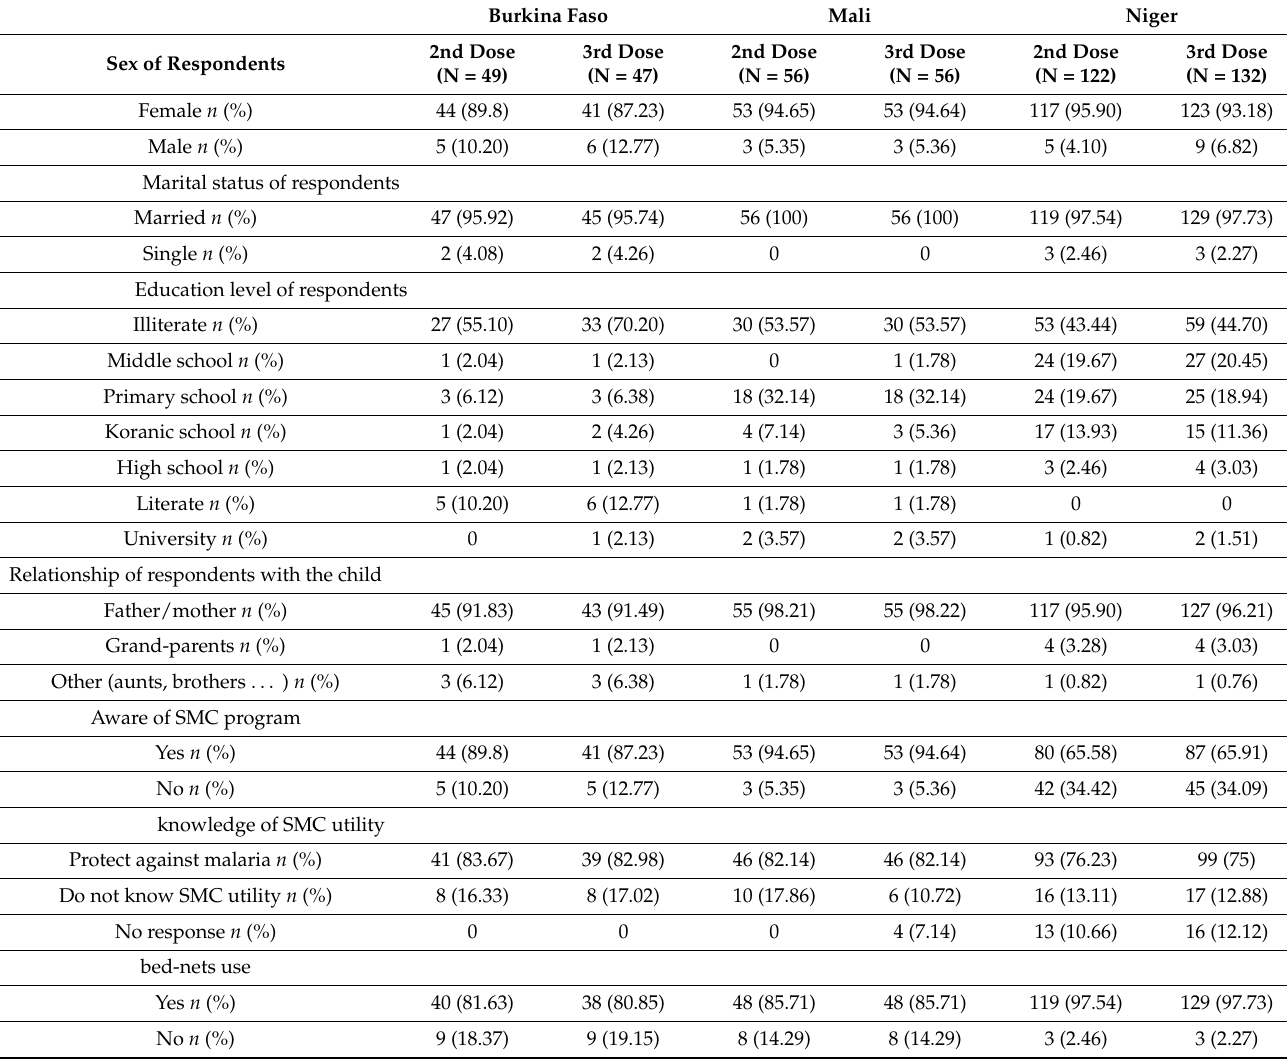
Table 4. Sociodemographic characteristics of parents who did not administer the second and third doses. Burkina Faso Mali